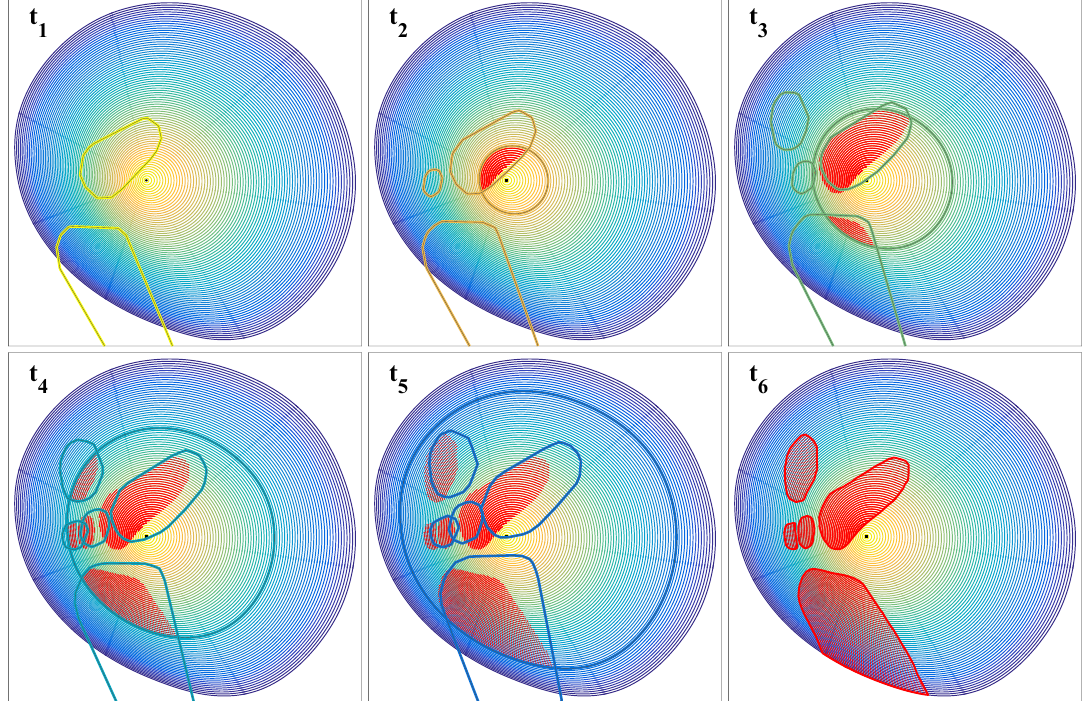
Figure 4. In the anisotropic case, the groundspeed is not equal to true airspeed and depends on the aircraft’s position and course. The inhomogeneous gridded wind data are taken from a GRIB file (see Section 2.2.1). When considering wind the resulting ECAs differ noticeably from those in Figure